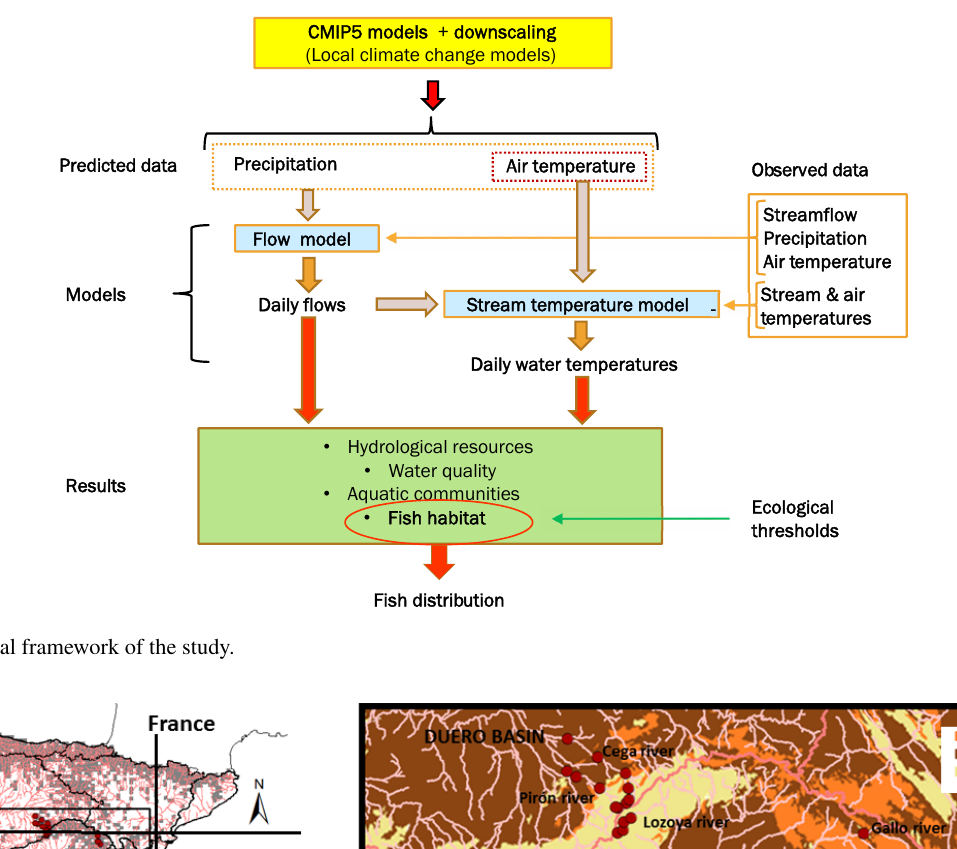
Figure 1. Logical framework of the study.